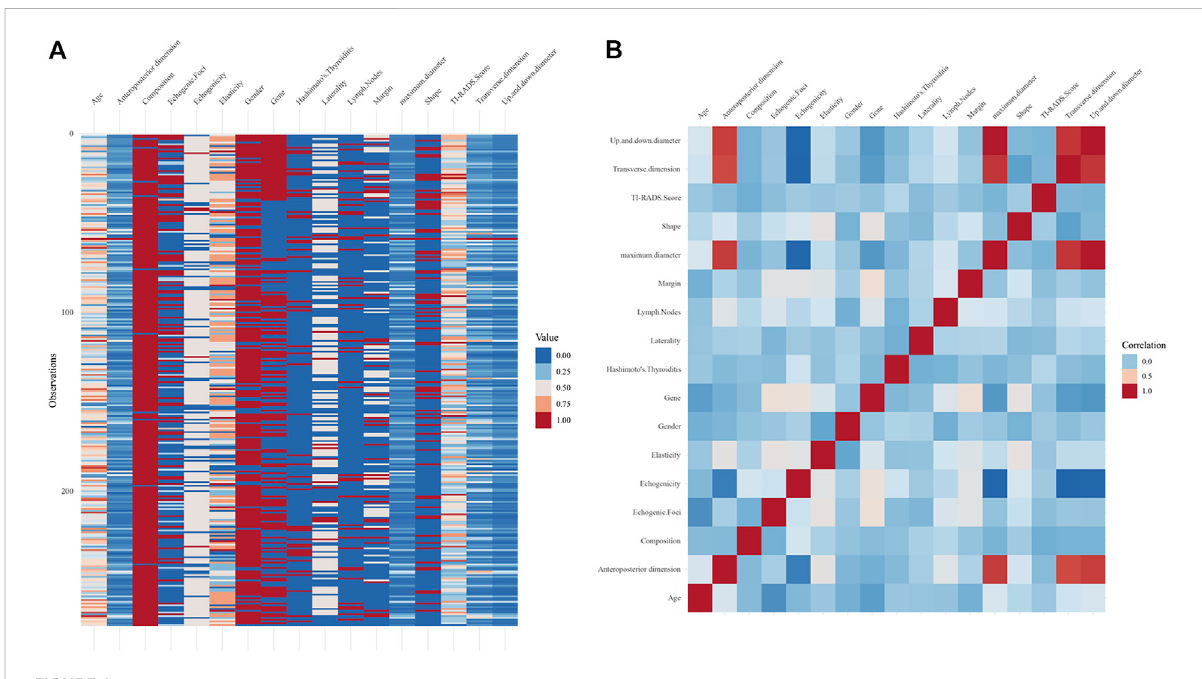
FIGURE 1 (A) Overview plot for all the included patients. (B) Heat map of the correlation for 17